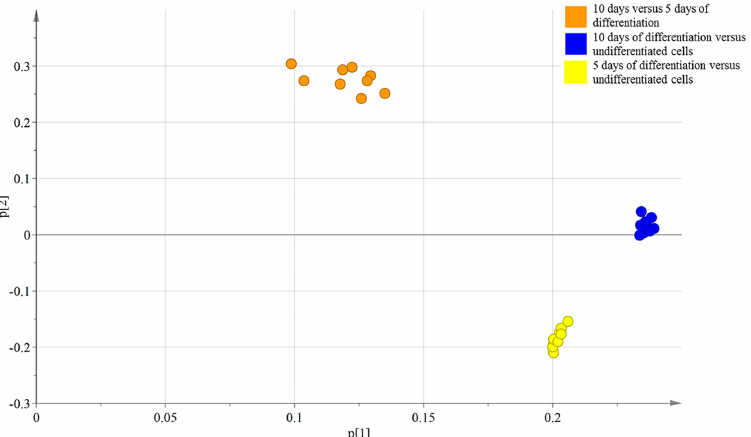
Fig 1. PCA plot of independent experimental seed-outs. The data clusters accordingto the different contrasts, i.e. 10 days vs 5 days of differentiation, 10 days vs undifferentiated, 5 days vs undifferentiated, showingrobustness of the cell model as well as technicalreproducibility. The first two principalcomponents explained 72.5% of the information (variation)of the dataset (for PC1: 55.7%, for PC2: 16.8%).